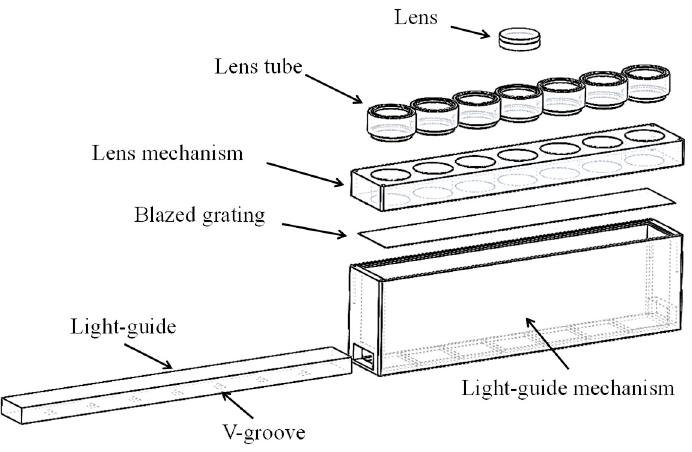
Figure 9. Exploded drawing of the practical module.